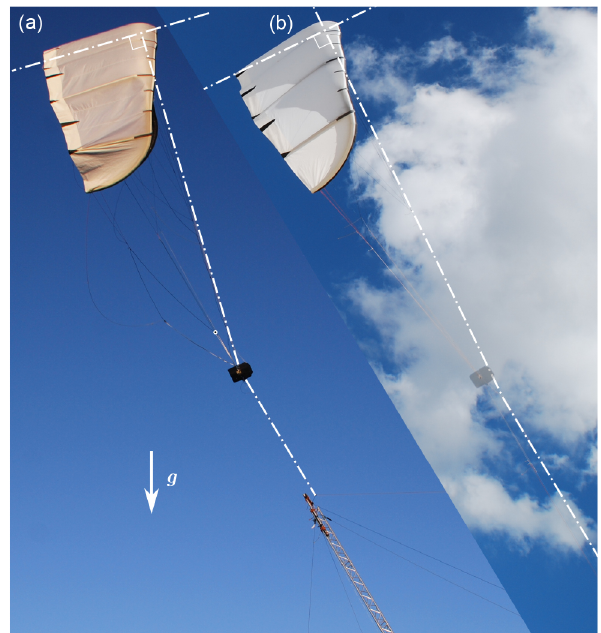
Figure 8. Side view of a kite partially depowered during a landing maneuver ( a ) and fully powered during a crosswind flight maneuver ( b ). The photo on the right was taken during a flight test in which the KCU was replaced by a ring that collected the joined power lines and the two steering lines and redirected them as a triplet of parallel lines to the pilot on the ground. The position of this ring is indicated by an overlaid transparent image of the KCU.